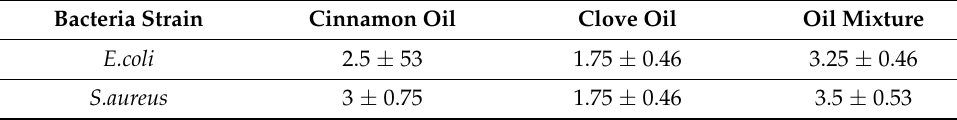
Table 2. Peripheral inhibition zones values (mm).